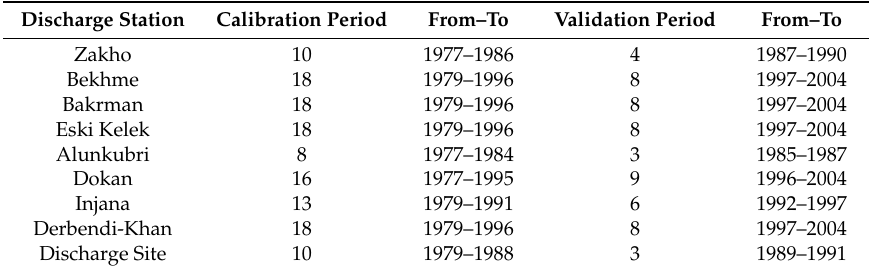
Table 3. Calibration and validation periods for each station in northeast Iraq.